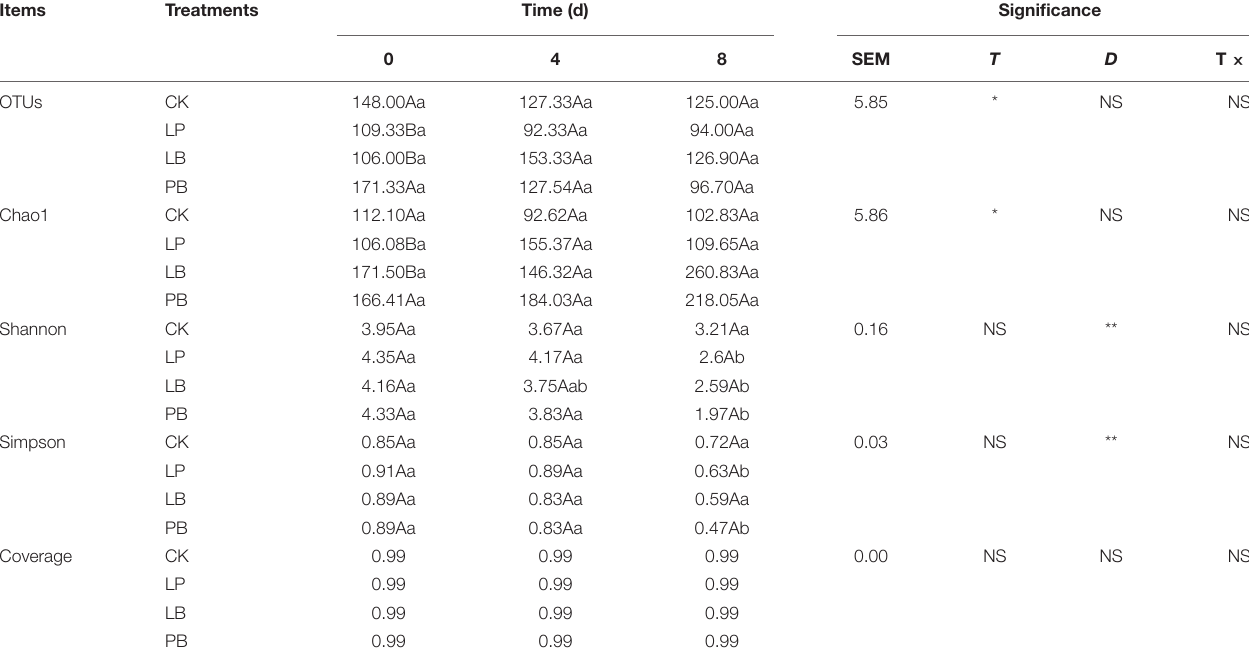
TABLE 5 | Effects of additives and days of aerobic exposure on fungal alpha diversity of Leymus chinensis silage. Items Treatments Time